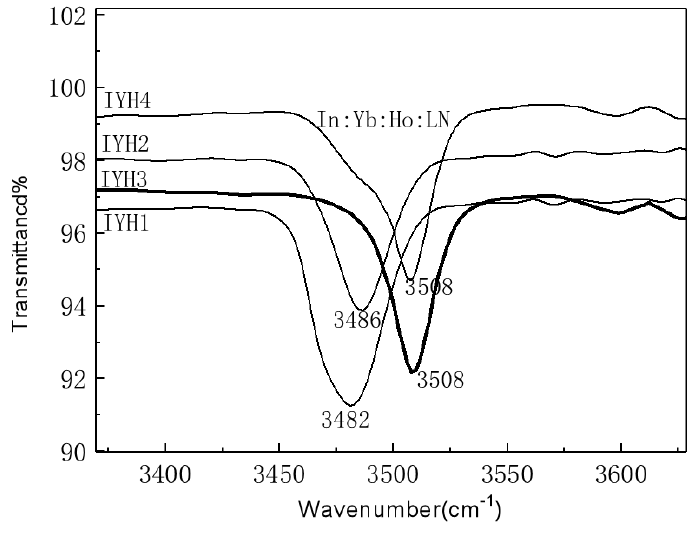
Figure 1. IR transmittance spectra of In:Yb:Ho:LiNbO 3